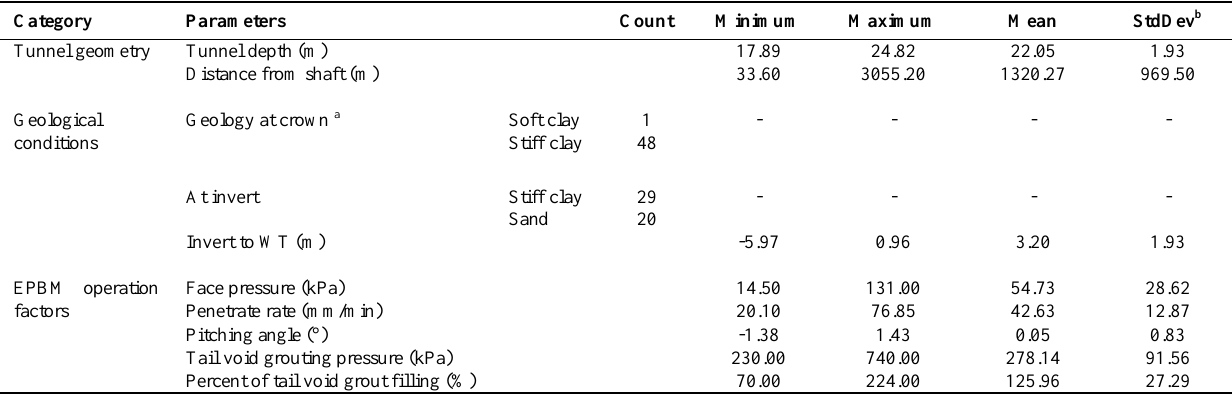
Table 1. Statistical Characteristic of data used in this